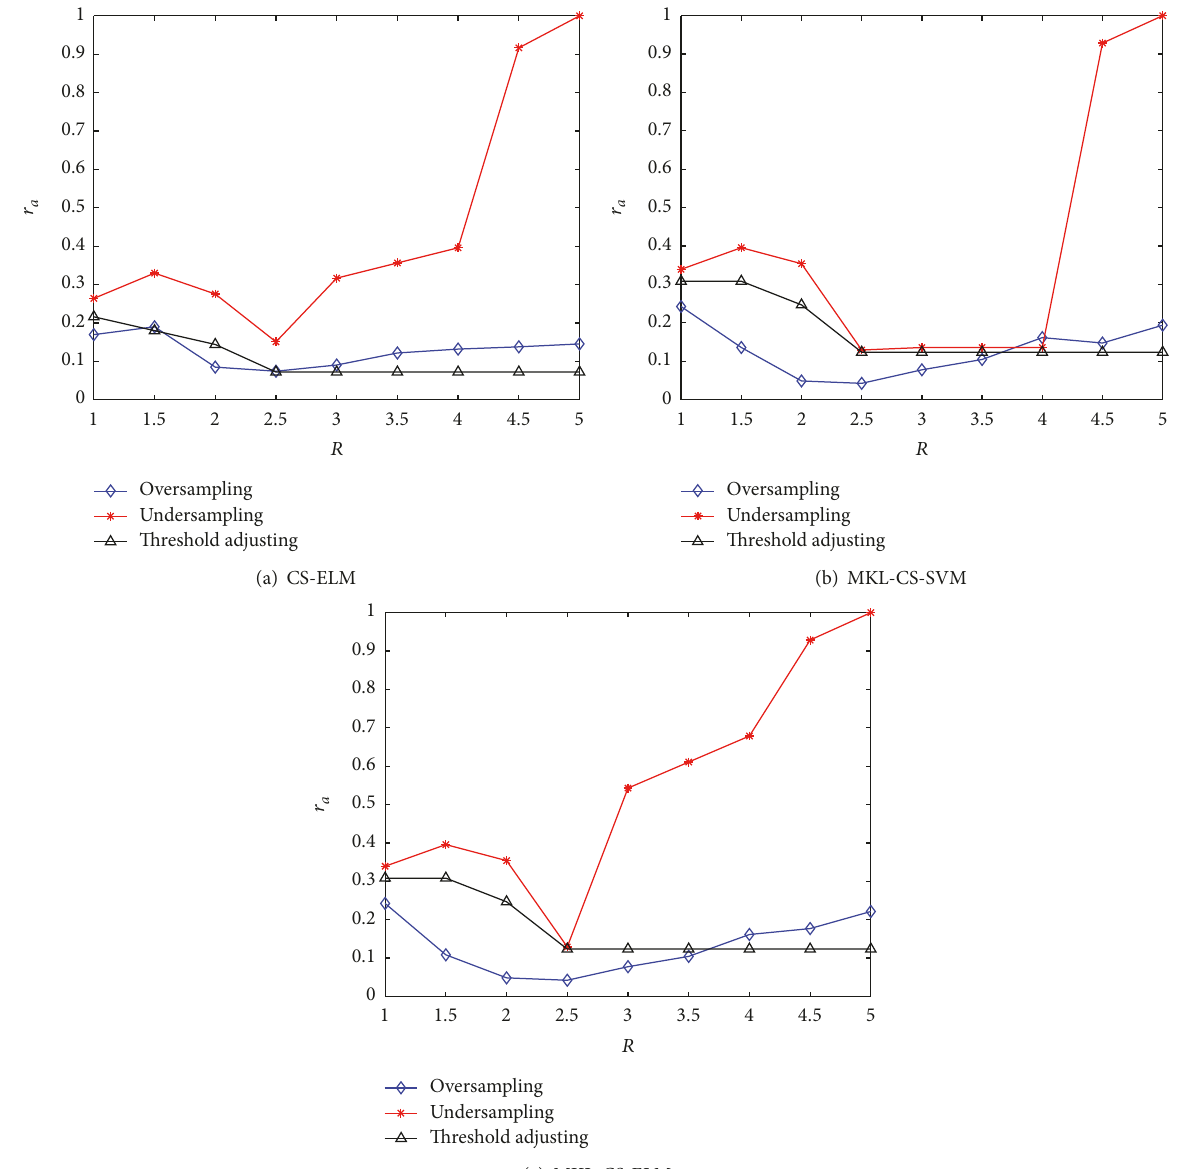
Figure 12: The performance comparisons of robust performance evaluation for different cost-sensitive